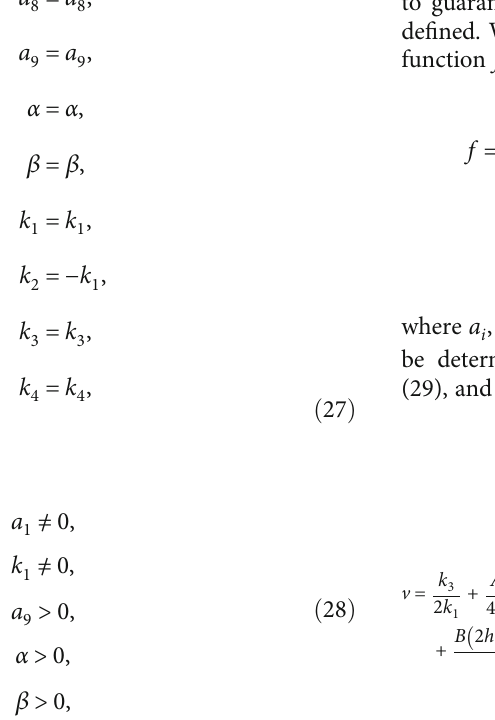
= 1 , a = 0 , a = 2 , a = 4 , a = 0 , a = 1 , α = 1 , β = 1 , k 1 4 5 6 8 9